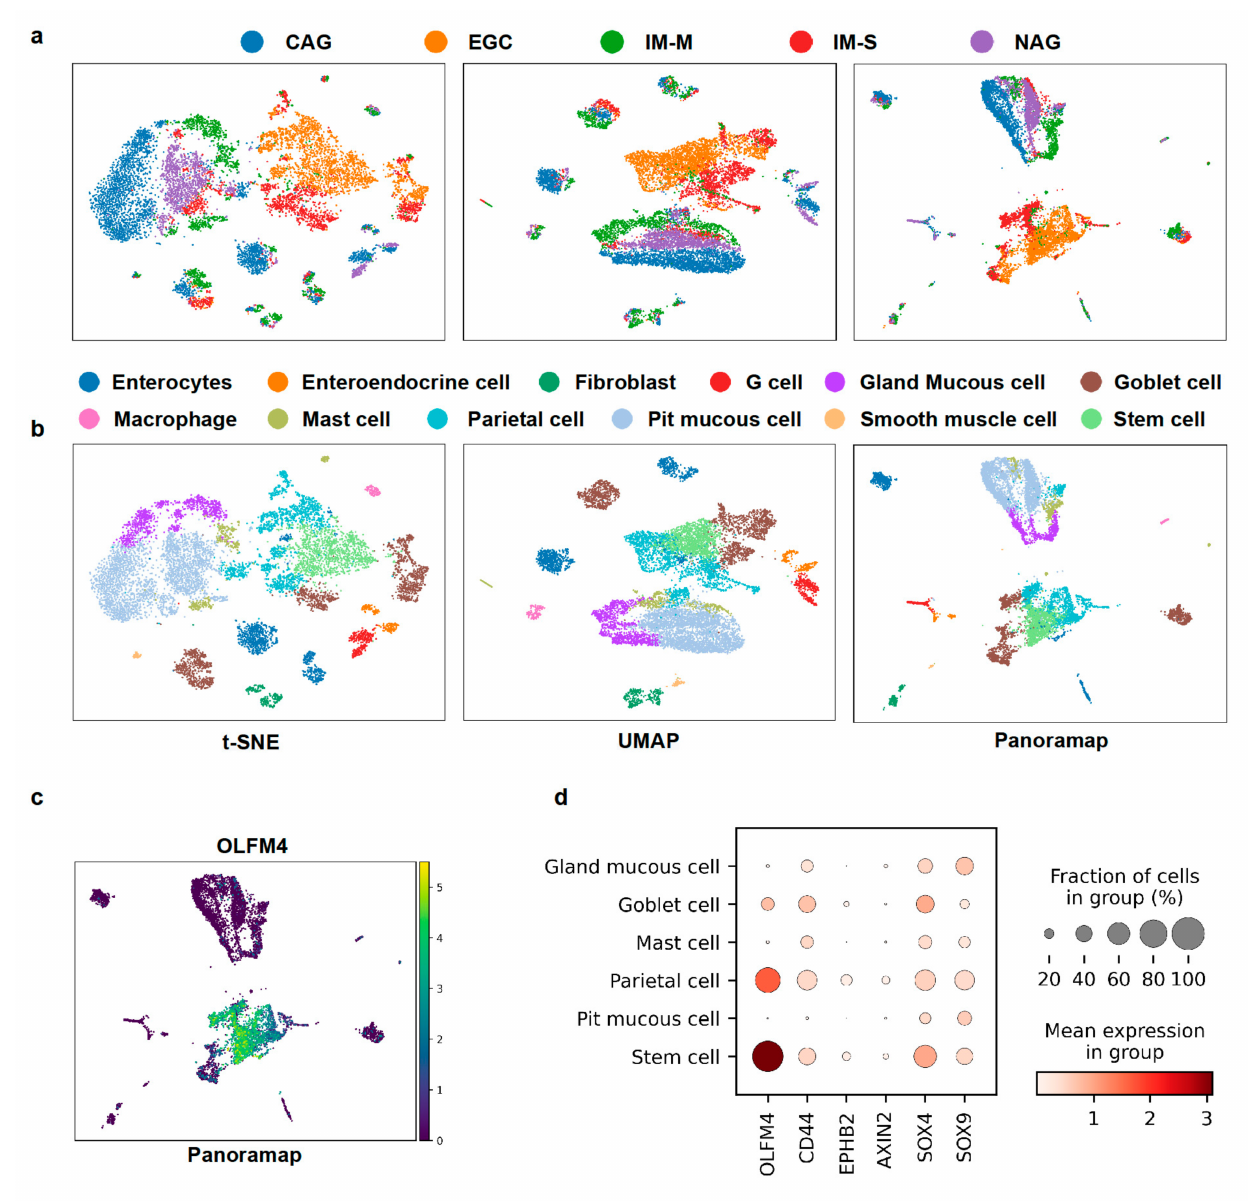
Figure 7. Panoramap helps distinguish premalignant/malignant lesions from other tissues. ( a ) For the gastric cancer dataset, embeddings from t-SNE, UMAP and Panoramap are colored according to the histological diagnosis provided in reference [44]. In Panoramap embedding, early gastric cancer lesion (EGC, orange color) and intestinal metaplasia (IM-S, red color) lesion of severe level are clearly separated from CAG, NAG and IM-M. ( b ) For the gastric cancer dataset, embeddings from t-SNE, UMAP and Panoramap are colored by cell types. ( c ) Scatter plot of gene expression for OLFM4. ( d ) Dot plot for intestinal stem cell gene expressions. The color represents the mean expression within each of the cell clusters and the dot size indicates the percentage of cells in the cluster expressing a gene. CAG, chronic atrophic gastritis; NAG, non atrophic gastritis; IM-M, intestinal metaplasia with mild